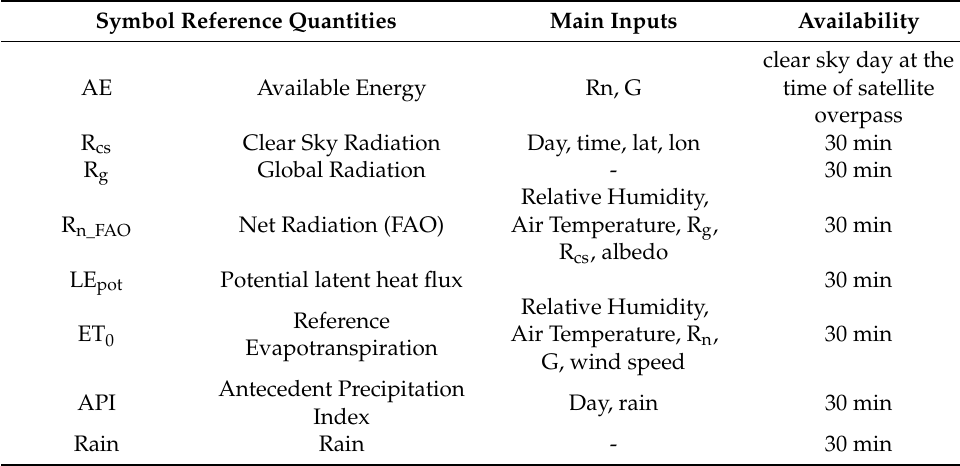
Table 2. Reference quantities ( q ) used to reconstruct evapotranspiration (ET). Symbol Reference